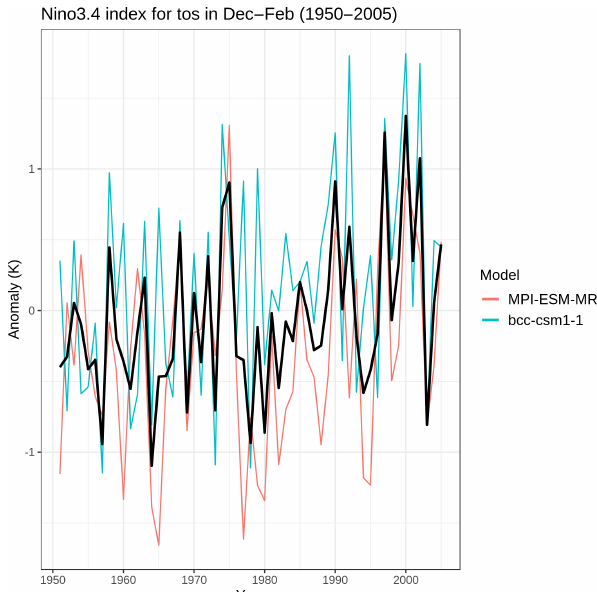
Figure 20. Time series of the standardized sea surface temper- ature (tos) area averaged over the Niño 3.4 region during bo- real winter (December–January–February). The time series cor- respond to the MPI-ESM-MR (red) and BCC-CSM1-1 (blue) models and their mean (black) during the period 1950–2005 for the ensemble r1i1p1 of the historical simulations. Produced with recipe_combined_indices.yml ; see details in Sect.